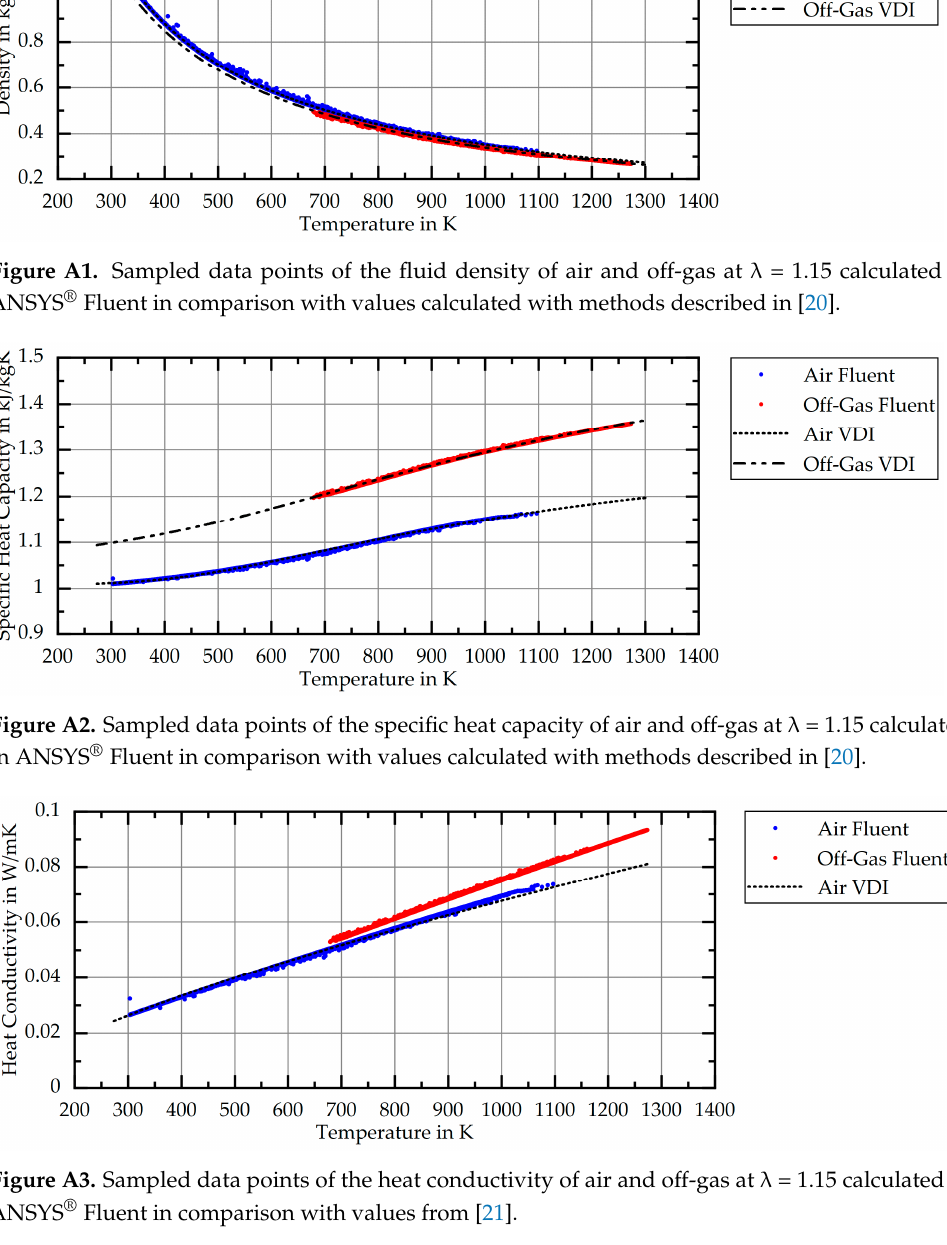
Figure A4. Sampled data points of the dynamic viscosity of air and off-gas at λ = 1.15 calculated in ANSYS® Fluent in comparison with values from [21]. References 1.